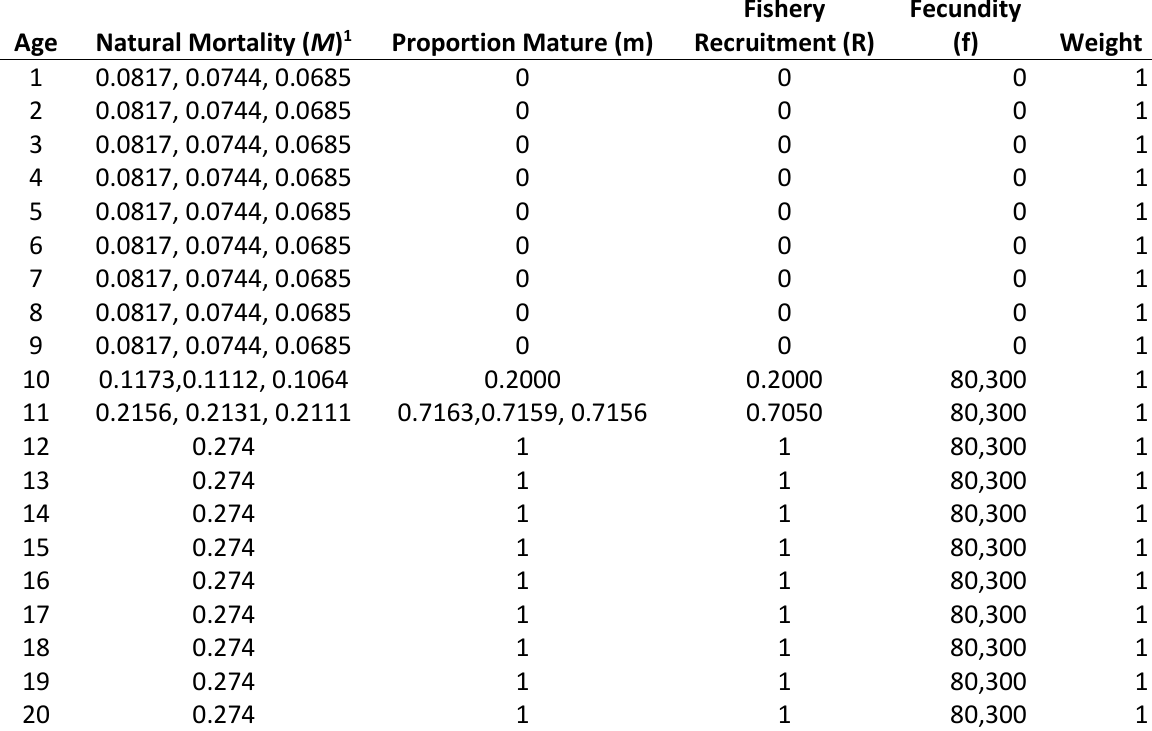
Table 49. Horseshoe crab life history parameters used in the egg- and yield-per-recruit